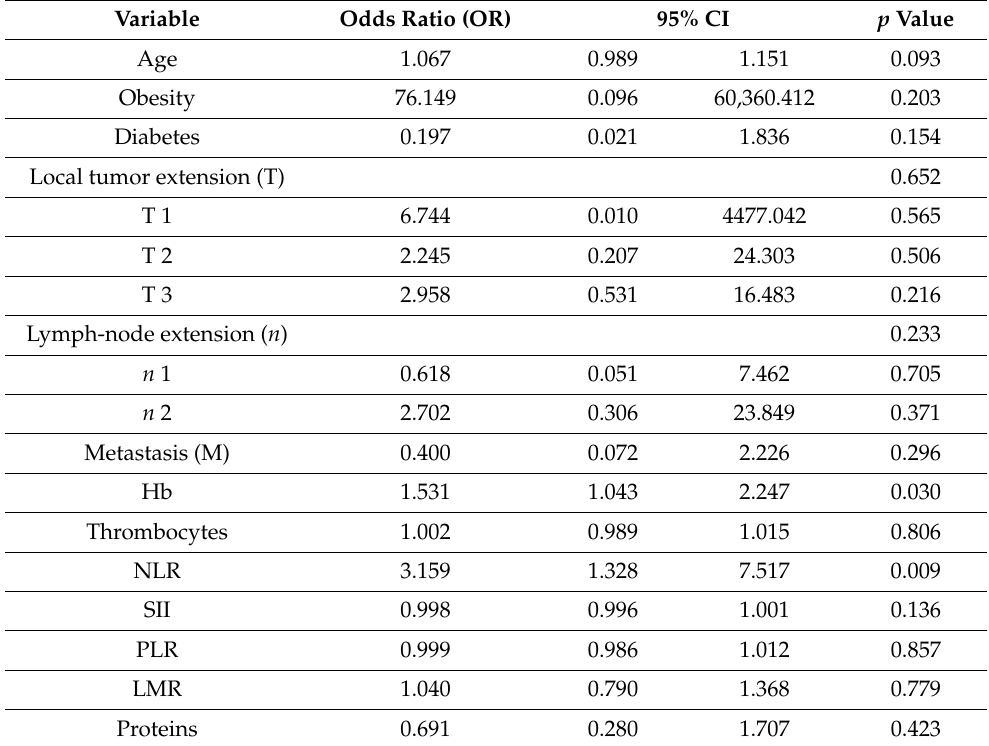
Table 5. Factors influencing postoperative leak rate in multivariate regression analysis. Variable